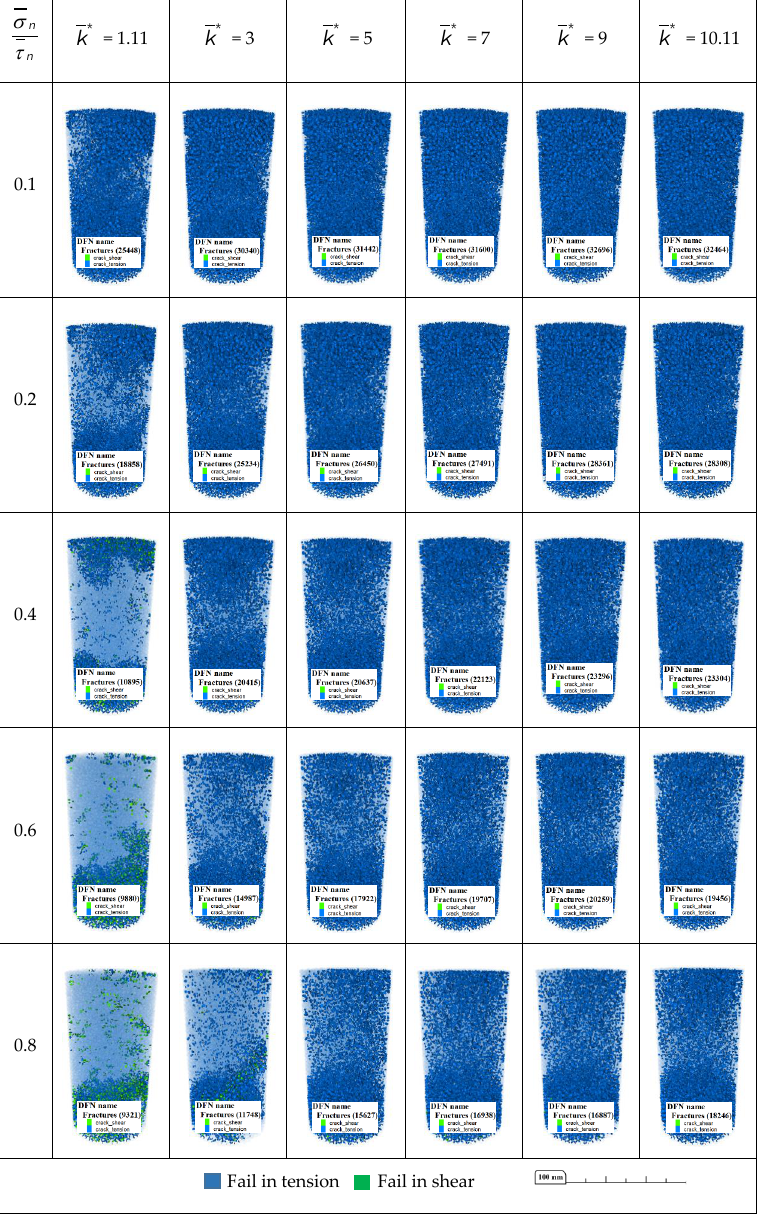
Figure 10. Propagation of micro-fractures in test specimens with di ff erent bond normal-to-shear ∗ sti ff ness ratios ( k ) for σ n / τ n <